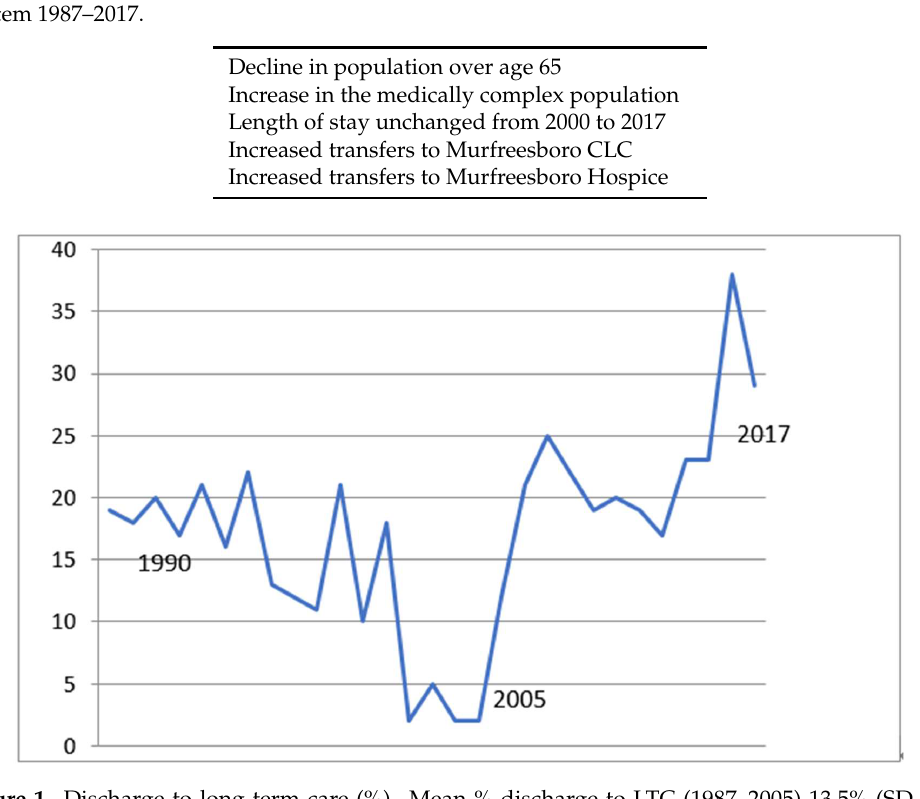
Table 1. Geriatric evaluation and management utilization trends, Tennessee Valley Healthcare System 1987–2017.